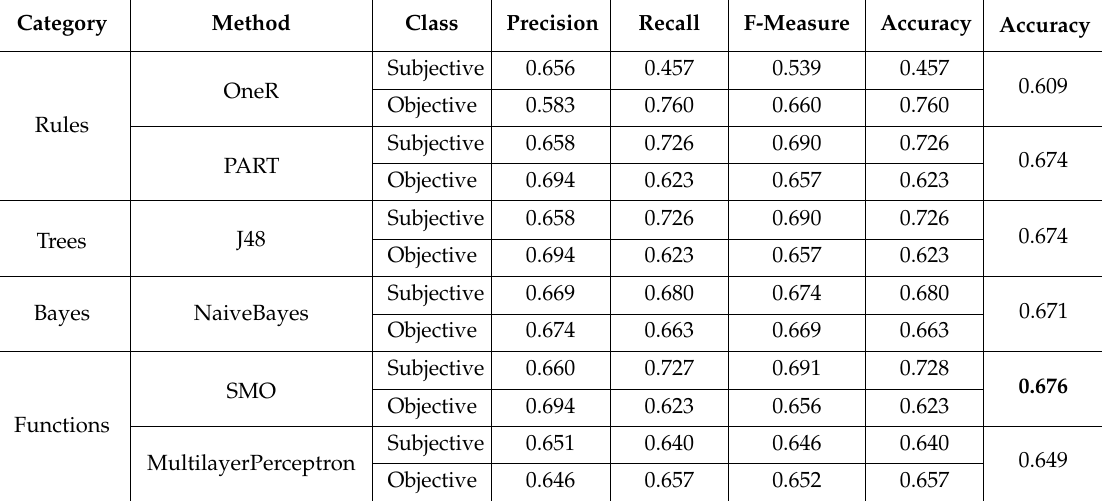
Table 6. Results for the lexical